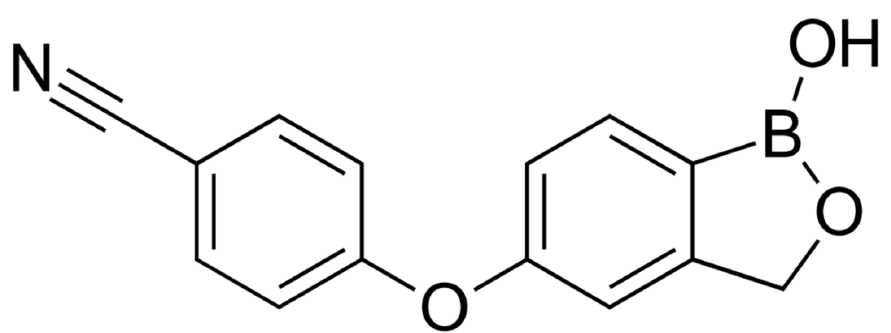
Figure 1. Chemical structure of Crisaborole.